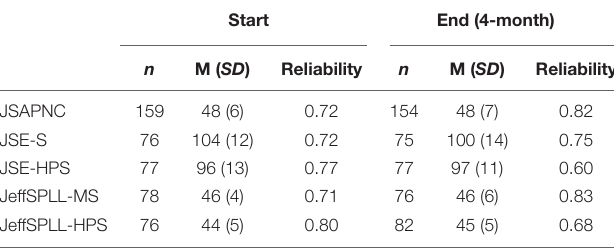
TABLE 1 | Descriptive analysis, reliability, and reliability of the Jefferson Scales of physician-nurse collaboration, empathy, and lifelong learning.